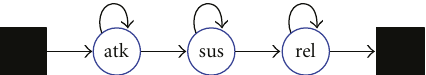
Figure 3: The state transition diagram of the indicator variable r τ . This figure visualizes the possible states that r τ can be in given the previous state r τ − 1 . Here atk, sus, and rel refer to the attack, sustain, and release parts of an event, respectively. The first black square can be either the silence or a release state. Similarly the second black square can be either a silence or an attack state. For example, given that r τ − 1 is the release state of event E i , then r τ can be either the same state as r τ − 1 (i.e., E i resumes) or it can be the silence state (i.e., E i ends) or it can be the attack state of a percussive event which is defined in the model (i.e., a new event starts). Similarly, r τ cannot be a sustain state if given that r τ − 1 is a release